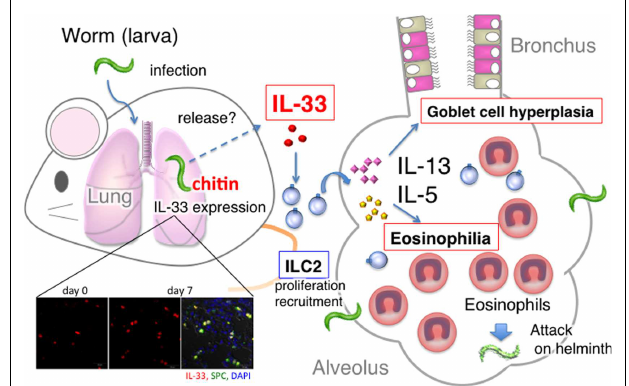
FIGURE 1 | Summary of host protective pulmonary eosinophilia . S. venezuelensis infection of Rag2 − / − mice induced severe eosinophilic inflammation, goblet cell hyperplasia, and accumulation of ILC2, and increased the number of IL-33 producing type II alveolar epithelial (ATII) cells. First, IL-33 from ATII cells induced and activated ILC2 to produce IL-5 and IL-13.Then, IL-5 and IL-13 in combination induced severe pulmonary eosinophilia. And, perhaps, these eosinophils, increase their capacity to kill helminth after stimulation with